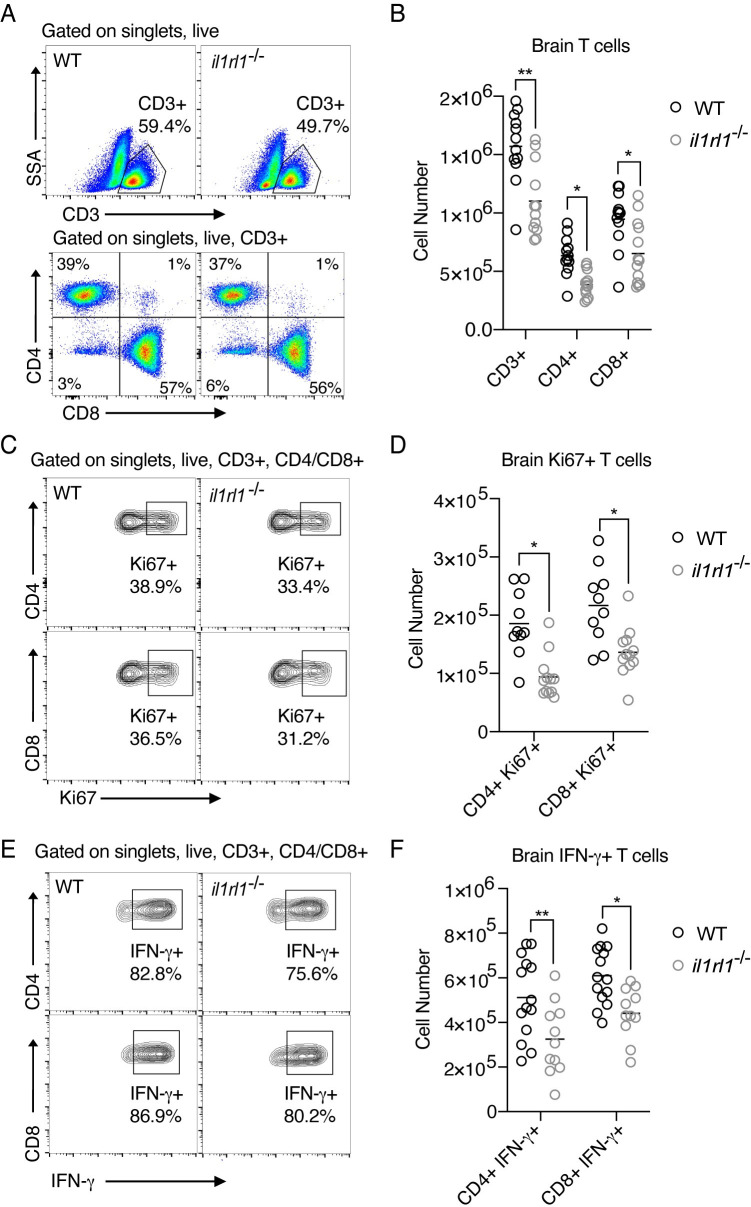
IL-33 signaling is required for adequate numbers and functionality of T cells in the brain during chronic T. gondii infection.(A and B) Representative flow cytometry plots (A) and quantification (B) of infiltrated total T cells in infected brain tissue four weeks-post infection. (C and D) Representative flow cytometry plots (C) and quantification (D) showing frequency of proliferating (Ki67+) T subsets in infected brain tissue. (E and F) Representative flow cytometry plots (E) and number (F) of IFN-γ-positive T cell subsets in infected brain tissue. IFN-γ was measured following ex-vivo re-stimulation of brain cells, incubated with Brefeldin A and PMA/ionomycin for 5 hours at 37°C (F). Statistical significance was determined by randomized block ANOVA (B,D,F), and each quantified panel displays three pooled independent experiments. * = p < .05, ** = p < .01, *** = p < .001.